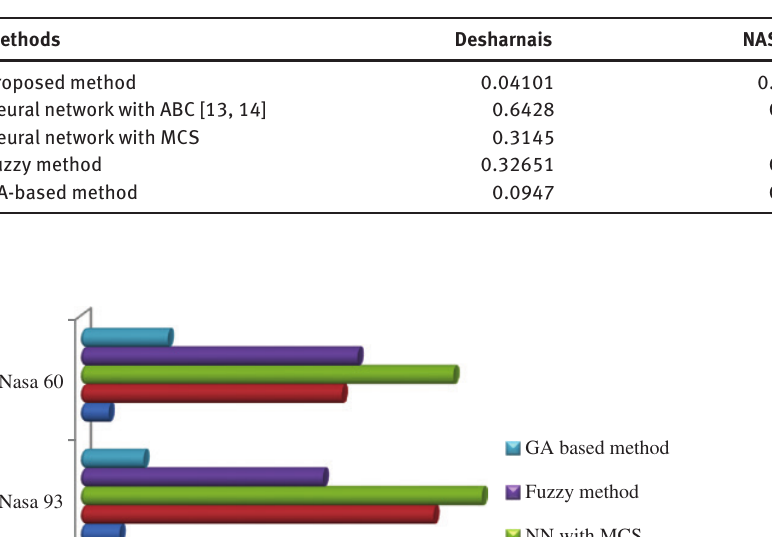
Table 5: Comparative Analysis of MMRE to Other Methods.